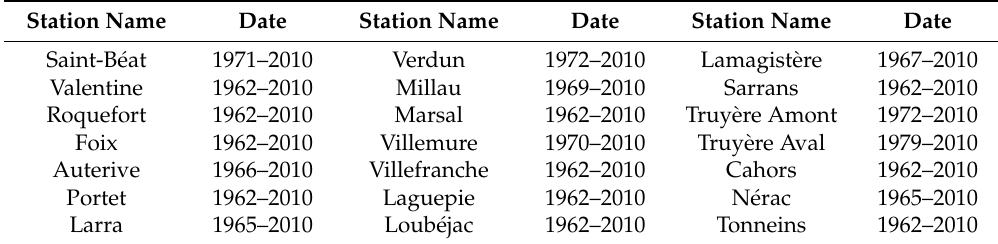
Table 2. Available chronicle for selected gauging